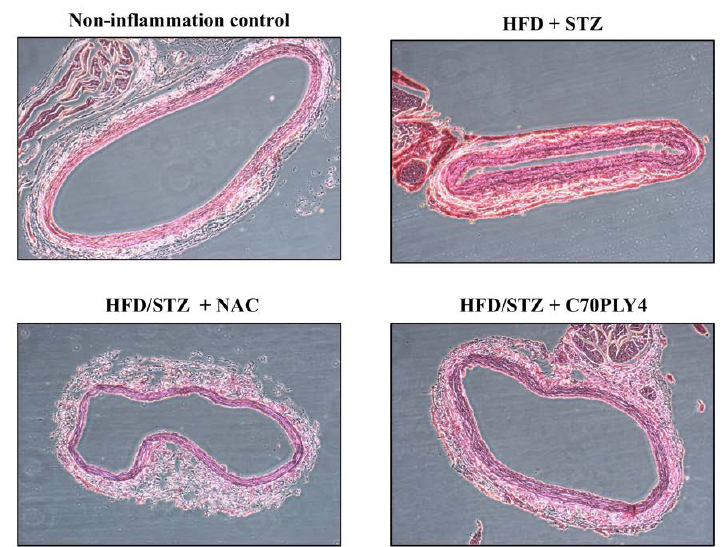
Figure 5. C70PLY4 attenuates atherosclerosis in streptozotocin (STZ)-injected high-fat diet (HFD)-fed rats. The rats were divided into four groups as follows: control rats (non-inflammation control), inflammatory rats (HFD + STZ), and inflammatory rats administered with NAC (HFD/STZ + NAC) or C70PLY4 (HFD/STZ + C70PLY4). The level of atherosclerotic plaque formation in the aorta was analyzed using HE staining.